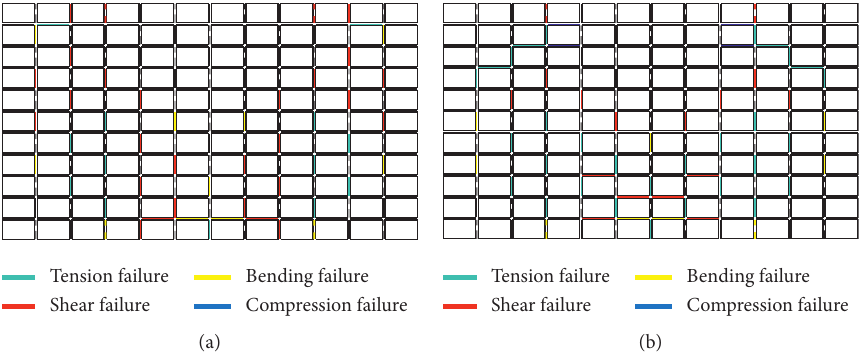
Figure 11: Interface damage close to the end of the numerical deep beam test: (a) P � 100kN; (b) P � 120kN. Continuous lines, mortar interfaces; dashed lines, inner block interfaces.